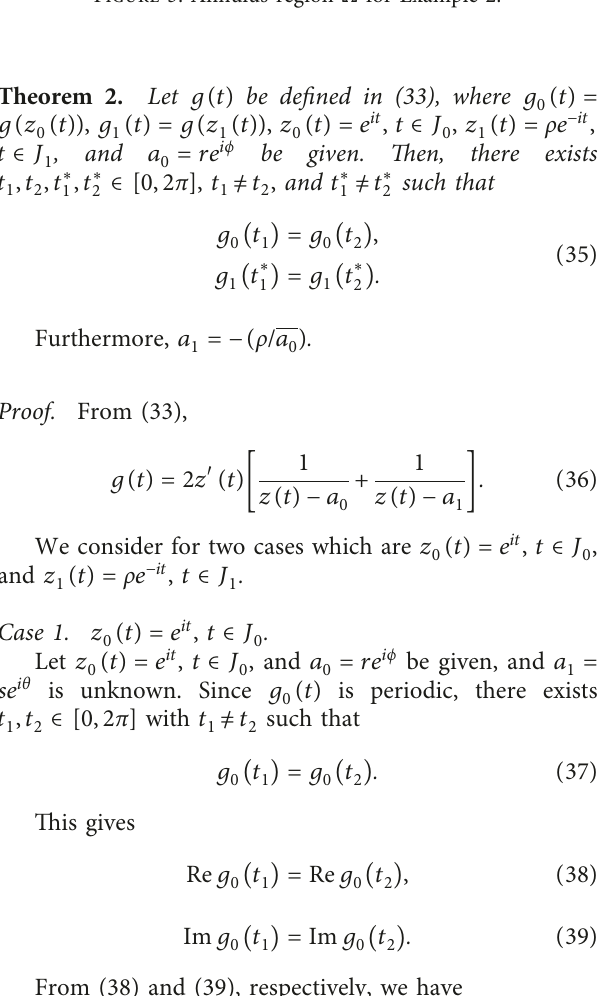
Figure 3: Annulus region Ω for Example 2.